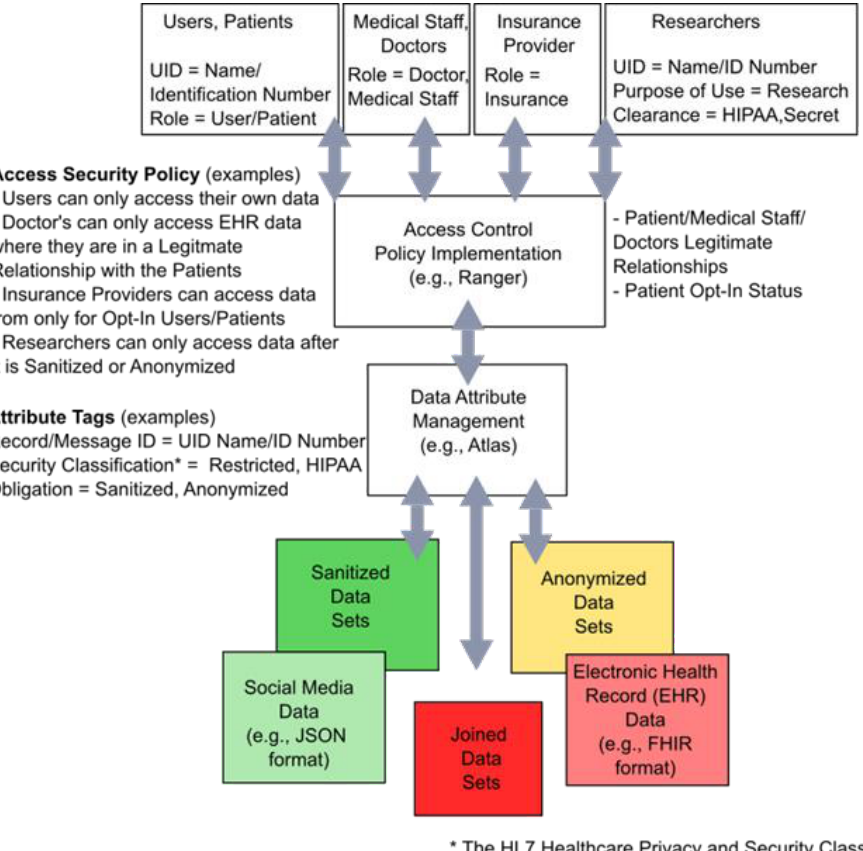
Figure 5. Attributes assigned and managed for AC policy decisions in the healthcare use case. The shades of the color red indicates sensitive data, shades of green indicates public data that may contain PII, and yellow indicates data where sensitive information has been